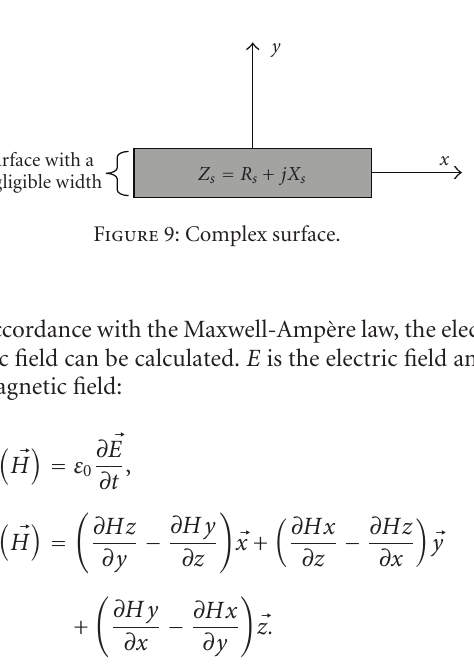
Figure 8: Beam steering e ff ects on the transient-radiated field.